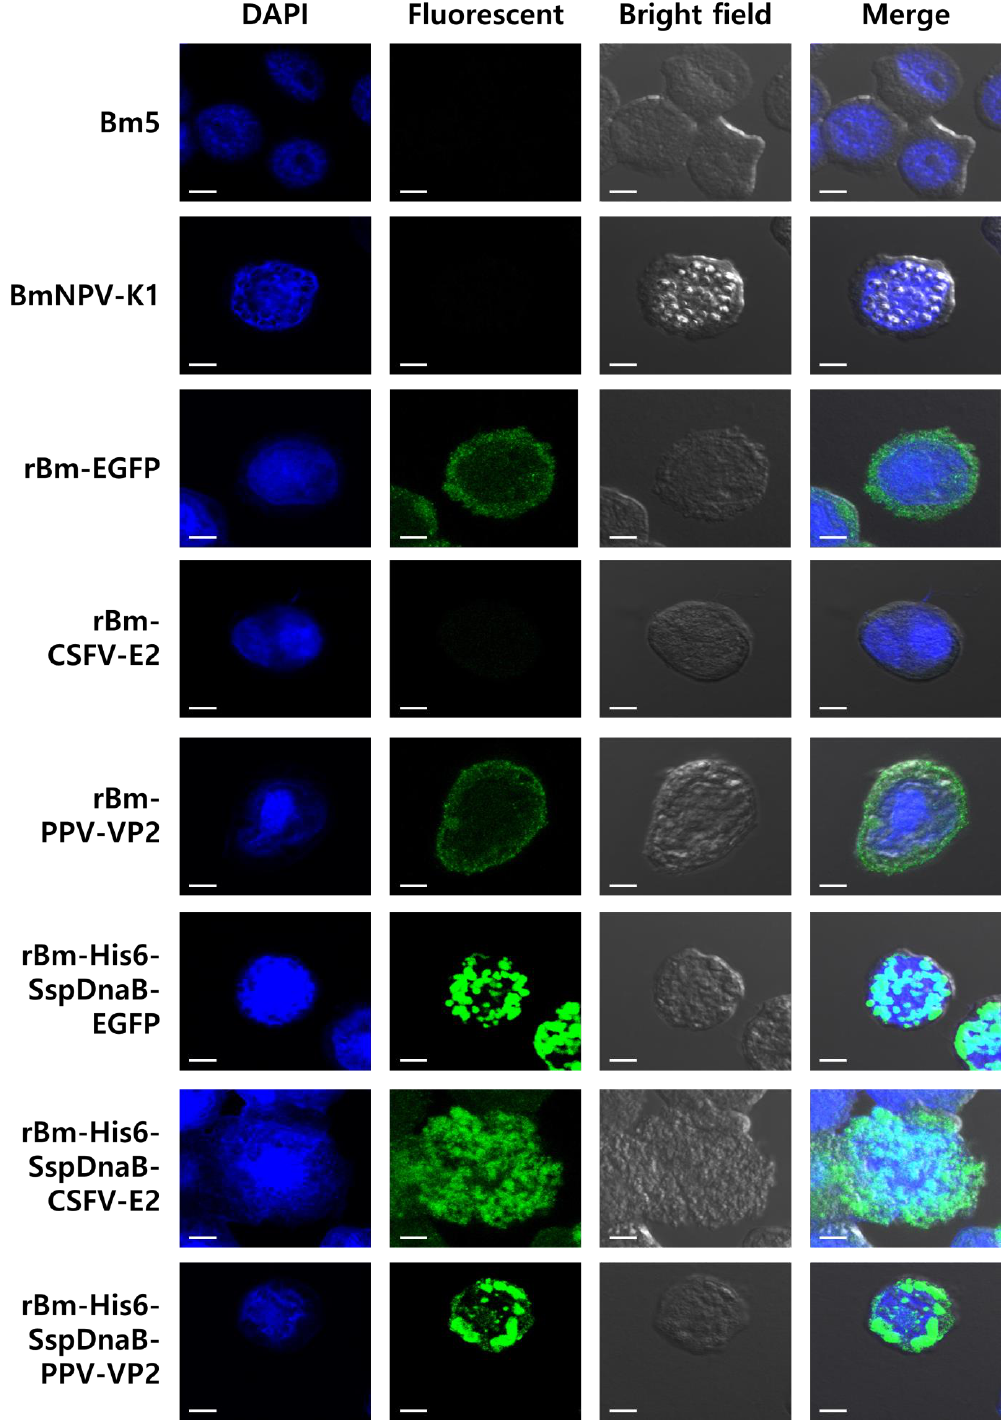
Figure 6. Intracellular distribution of the Ssp DnaB mini-intein-fusion proteins in Bm5 cells. Immunofluorescent staining of the Ssp DnaB mini-intein-fusion and non-fusion proteins was performed using antibodies against E2 or VP2 (secondary goat anti-mouse or rabbit Alexa-Fluor 488, green). Fluorescence was examined in Bm5 cells infected with viruses at three days post-infection. DAPI (2-(4-Amidinophenyl)-6-indolecarbamidine dihydrochloride) staining showing the location of the nuclei. Combined fluorescence and DAPI staining showing the intracellular location of the mini-intein fusion proteins (Merge). The location of recombinant proteins was observed using a confocal laser scanning microscope. Scale bar indicates 10 µ